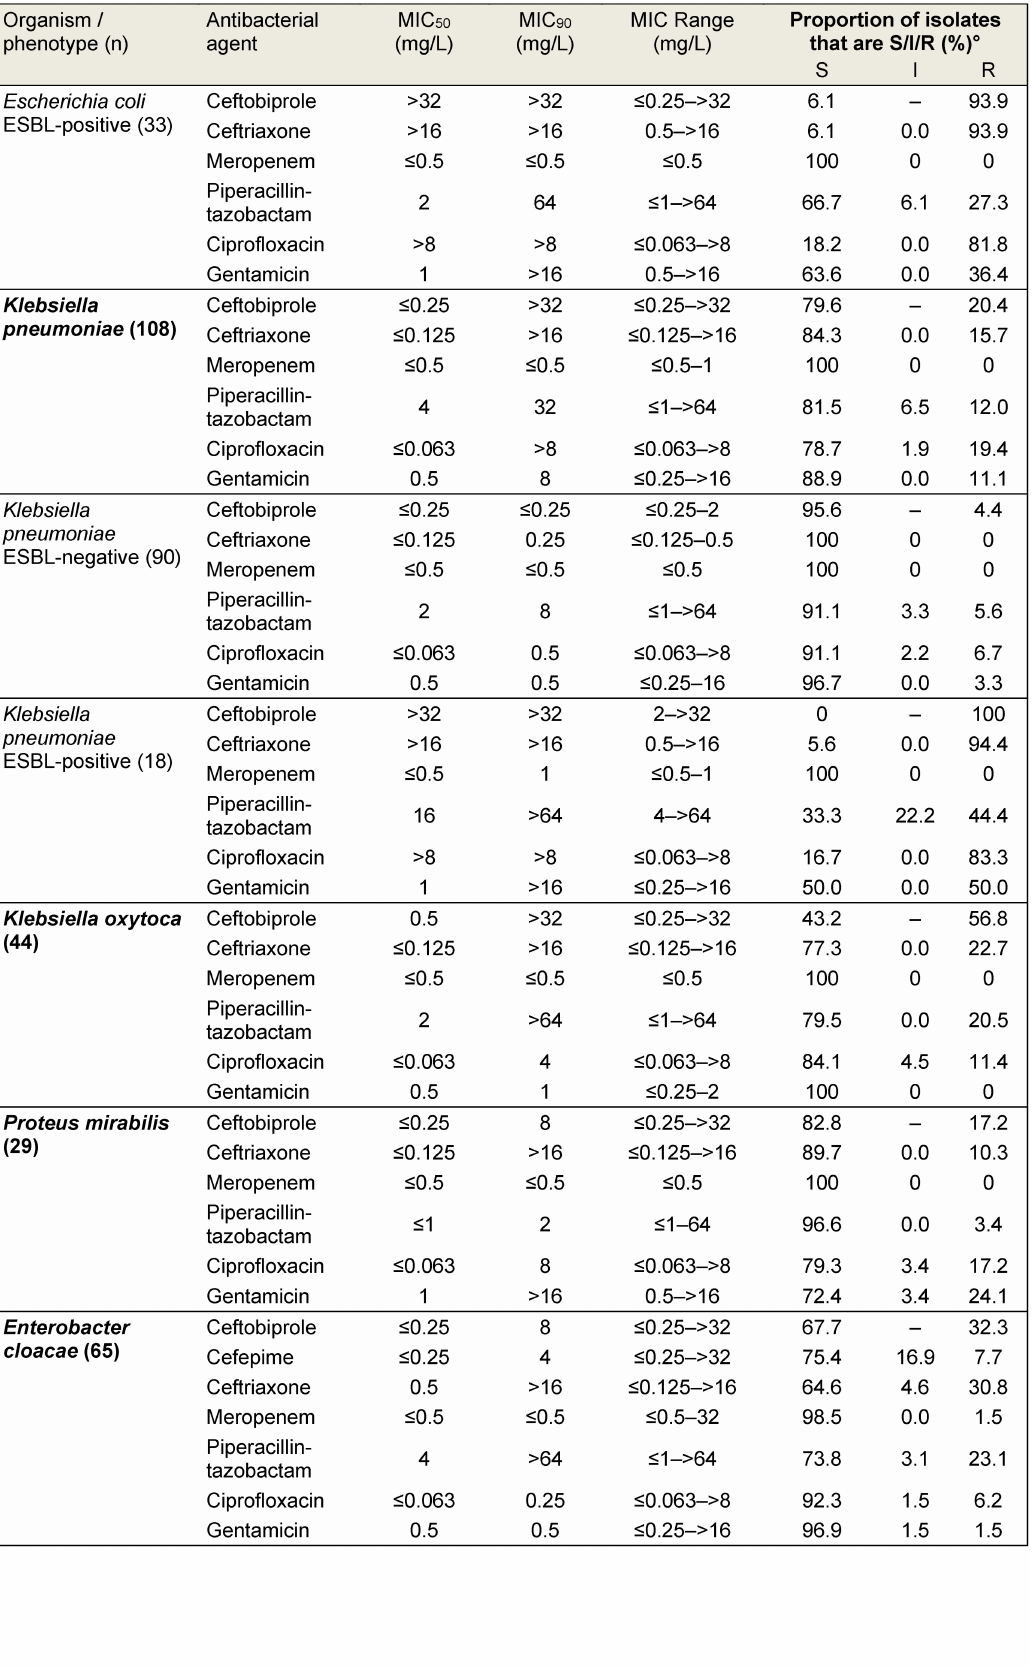
Table 3: In vitro activity of ceftobiprole and comparators against clinical isolates of most frequent bacterial species